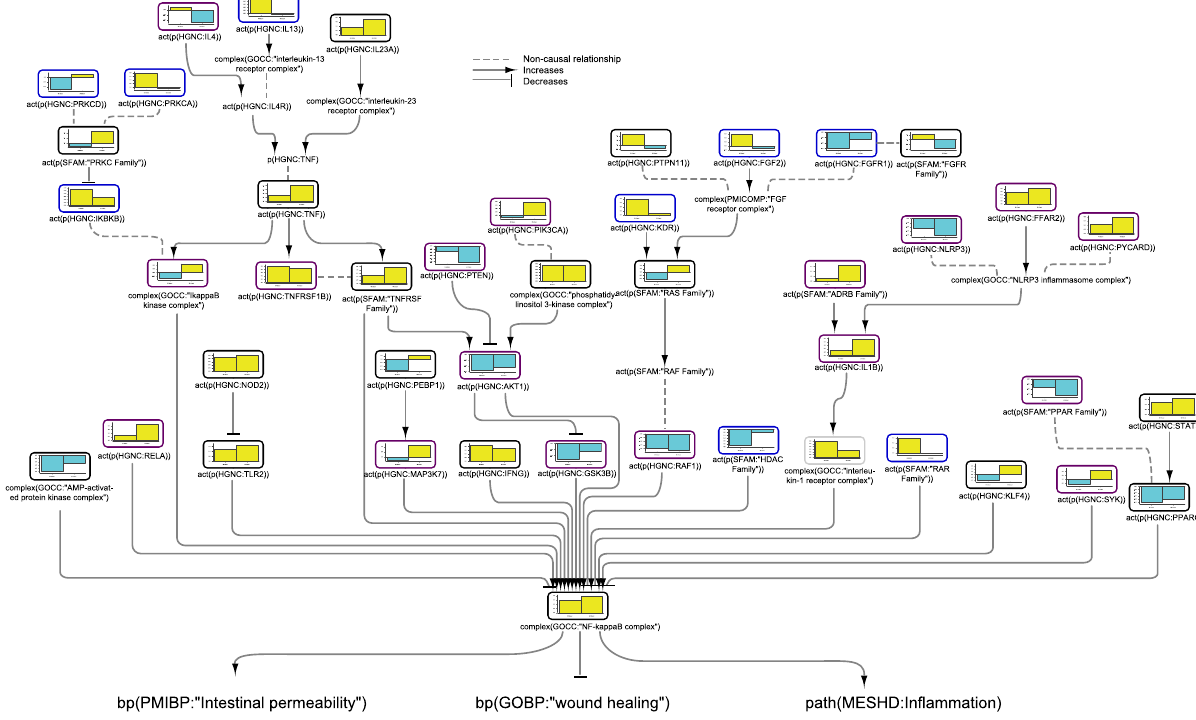
Figure 2. Impact of IBD on signalling pathways leading to NF-κB activation in colonic mucosa. The subgraph extracted from the merged IBD network model shows the iNode enrichment score for each node when scored with comparative transcriptomic data from IBD-affected versus healthy control colon samples. The values are not comparable between the graphs, and the scale is adjusted on the basis of the highest value for each node. Most intermediate nodes that were not scored have been removed for simplicity (The complete results are in Supplementary file 1). Black outlines indicate nodes that were significantly impacted in both CD and UC samples; blue outlines indicate nodes that were significantly impacted in CD samples; and purple outlines indicate nodes that were significantly impacted only in UC samples. The directionalities are shown as yellow or turquoise bars for inferred upregulation or downregulation, respectively. The order is as follows: 1) CD and 2) UC. Abbreviations: act, protein activity; p, protein abundance; bp, biological process. HGNC is the namespace for human proteins; GOBP is the namespace for biological processes; MESHD is the namespace for diseases; and GOCC is the namespace for complexes. SFAM and PMIBP are custom namespaces for protein families and biological processes, respectively. The figure was created using Cytoscape v3.7.1 (https:// cytos cape. org). The Cytoscape graph was then exported to pdf and the layout was further modified for better readability in Adobe Illustrator 2019 (https:// adobe.